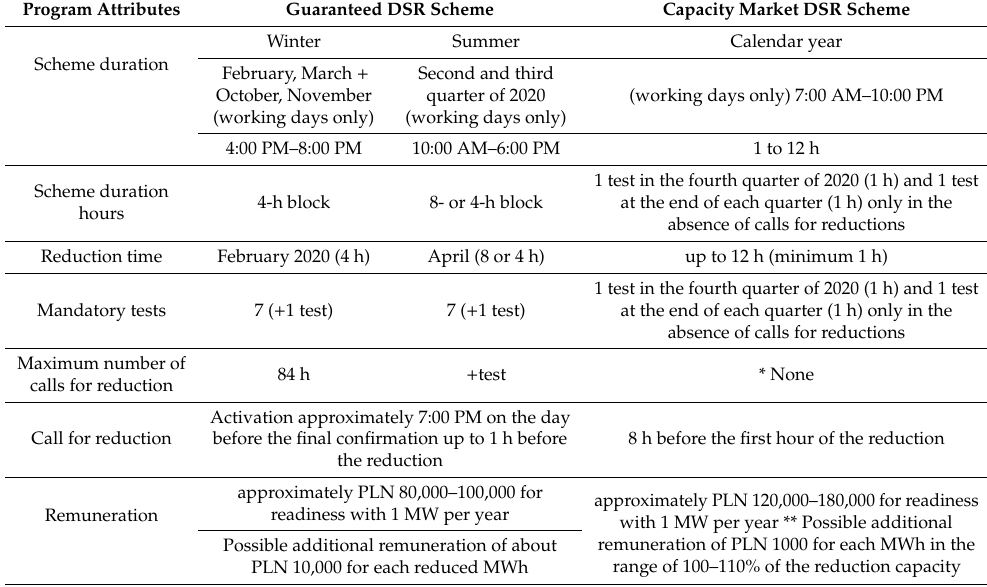
Table 2. Key di ff erences between DSR